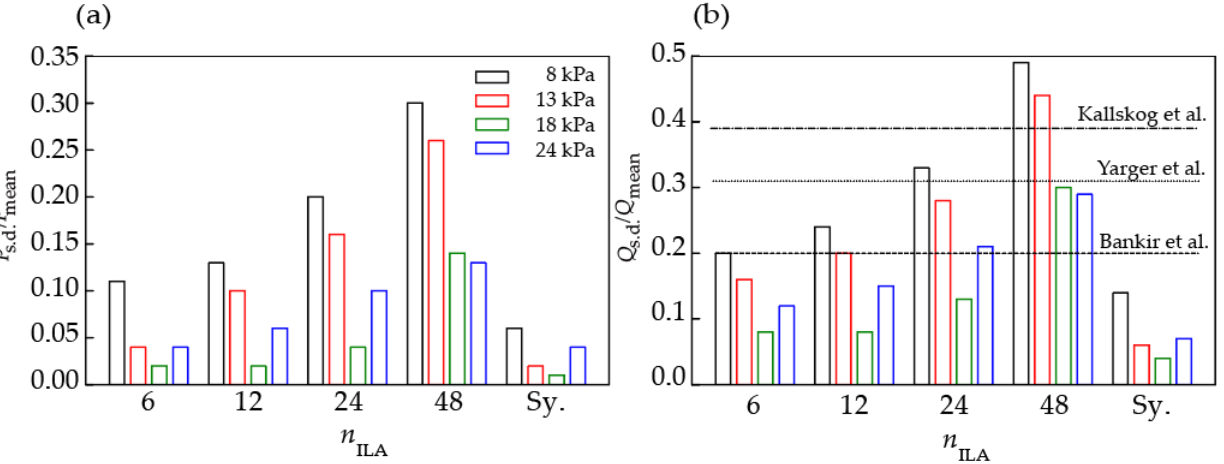
Figure 9. ( a ) Relative standard deviation (RSD) of glomerular pressure 𝑃 s.d. /𝑃 mean and ( b ) AA flow rate 𝑄 s.d. /𝑄 mean as a function of the number of vessels, 𝑛 ILA , of the asymmetrical model (Sy. is the symmetrical model) under the conditions of 𝑃 inlet = 8.0 (black), 13.0 (red), 18.0 (green) and 24.0 (blue) kPa, respectively. References are also illustrated: Kallskog et al. [3] (dashed dotted line); Table 2 from Yarger et al. [4] (dotted line) and Figure 1 from Bankir et al. [6] (dashed line).